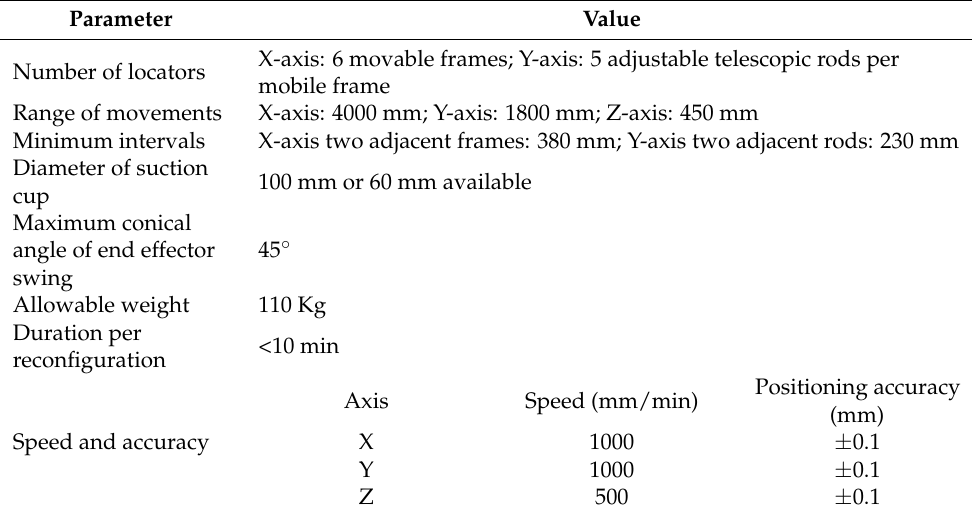
Table 1. Master data of reconfigurable